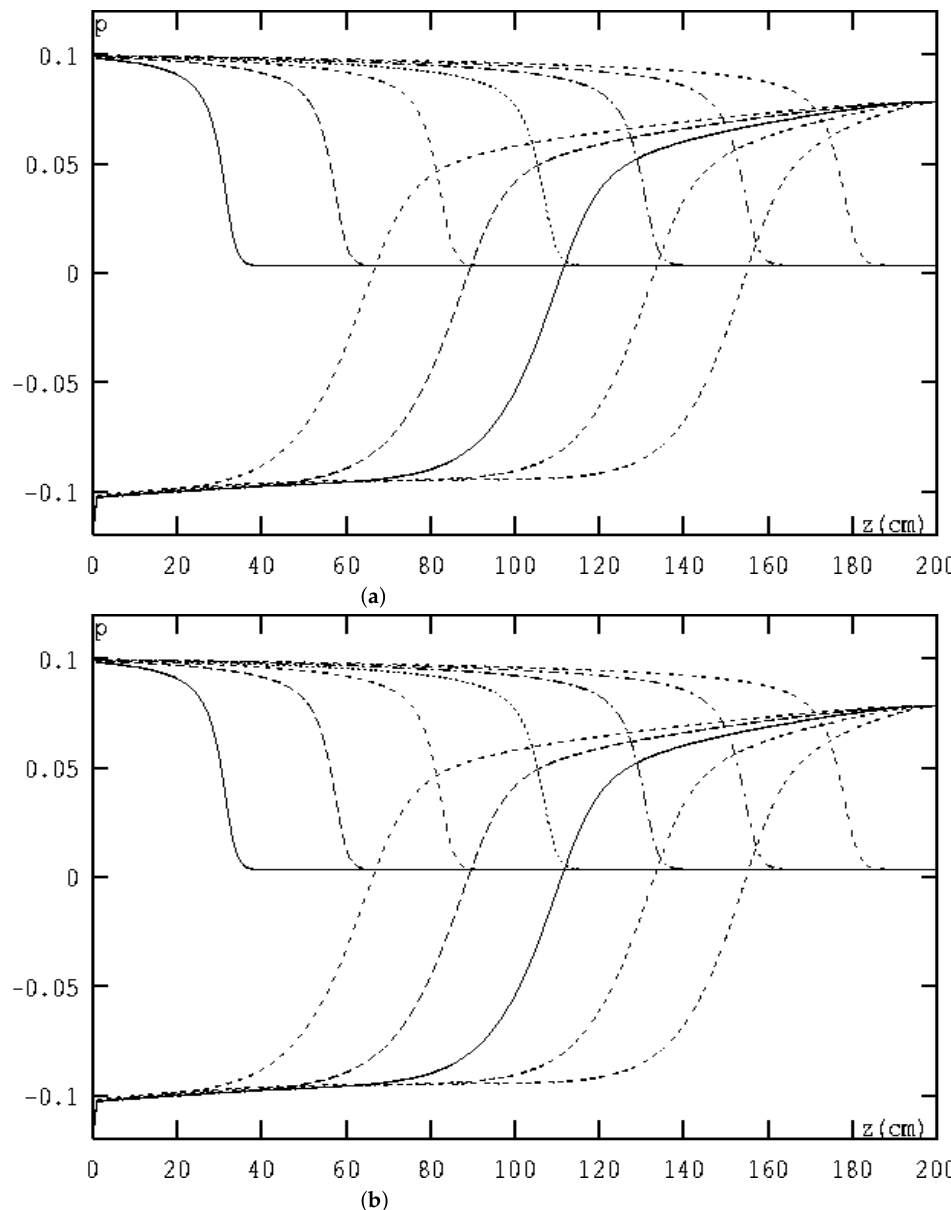
Figure 4. ( a ) These curves are the MFE solutions of infiltration and evaporation water flux at t = 60 h, 120 h, . . . , 420 h, 480 h, . . . , 840 h, respectively. ( b ) These curves are the MFE solutions of infiltration and evaporation water flux at t = 60 h, 120 h, . . . , 420 h, 480 h, . . . , 840 h,